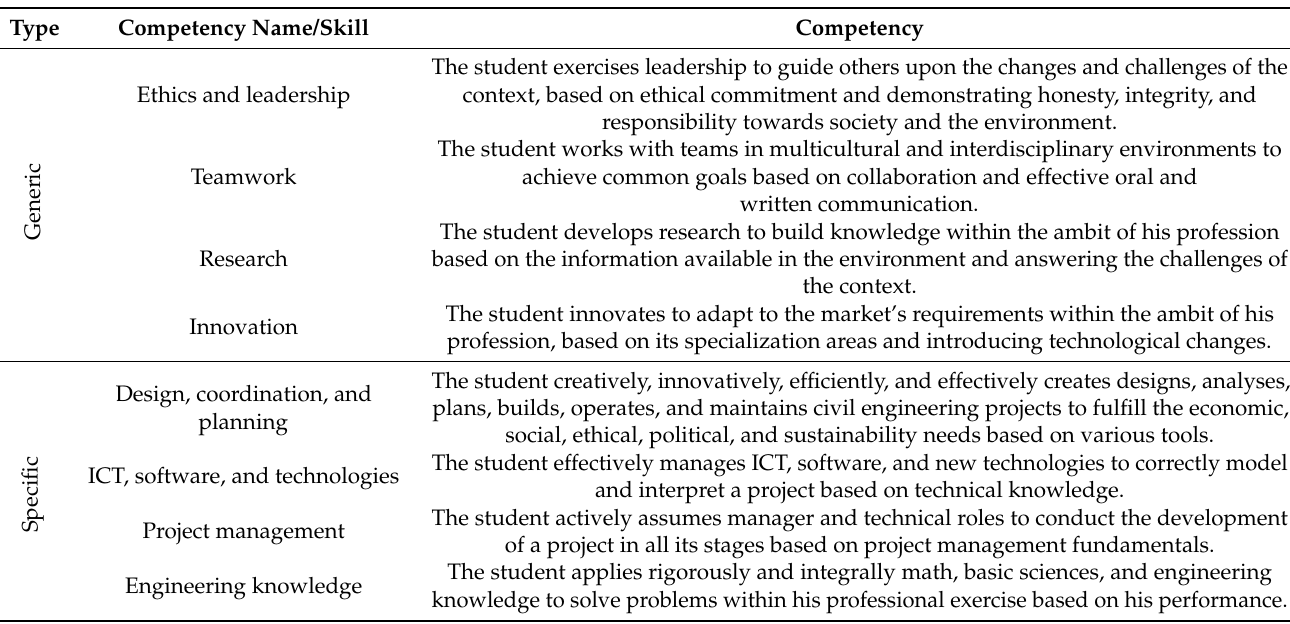
Table 7. Competencies for the civil engineering graduation profile.